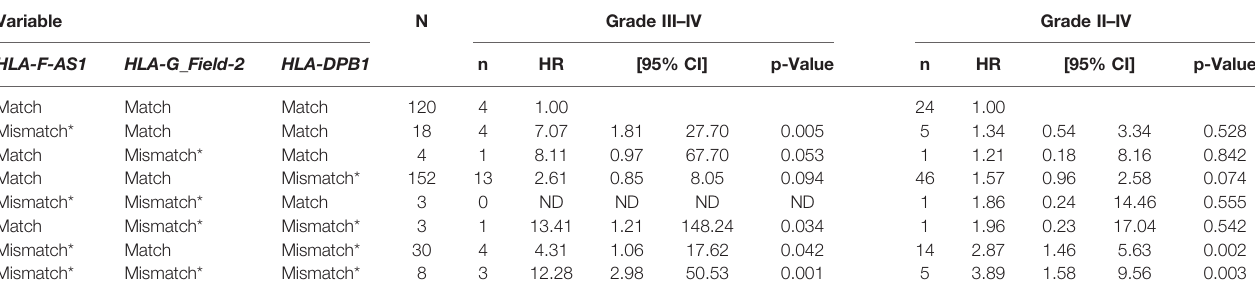
TABLE 6 | Strati fi ed analysis of HLA-F-AS1 , HLA-G , and HLA-DPB1 matching on aGVHD.